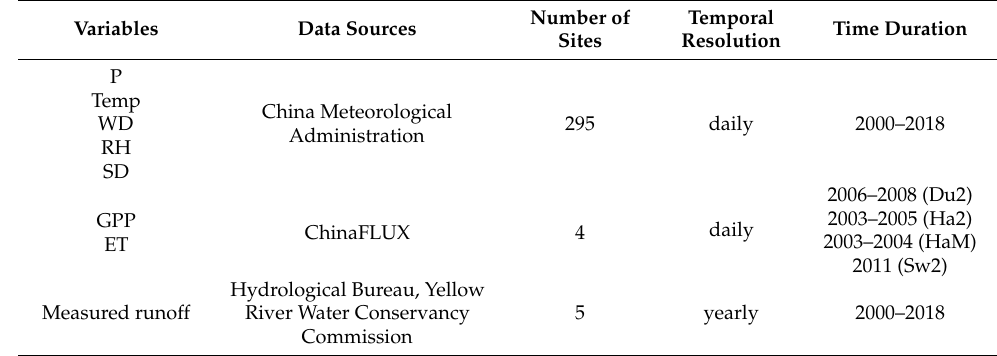
Table 2. In situ measurements from gauging stations and meteorological stations used in this